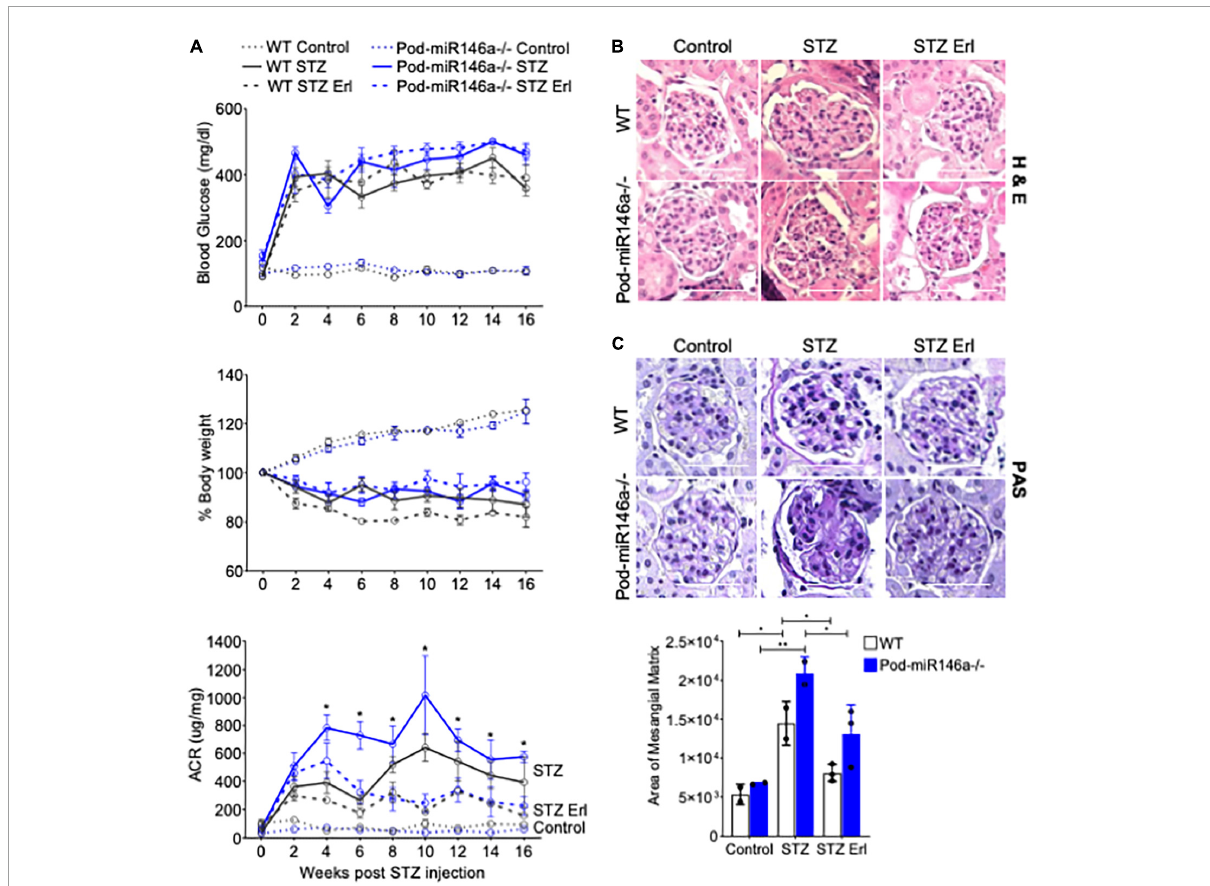
FIGURE4 STZ accelerates glomerular injury in Pod-miR-146a − / − mice that is attenuated by erlotinib. (A) (Top) Graph showing levels of hyperglycemia in various animals, as measured by serum glucose levels (mg/dL) in each of the six groups, as indicated, post STZ administration and at various time-points, as indicated. Data shown are mean ± SEM ( n = 5). Treatment with erlotinib starting at 4 weeks after STZ-induction did not result in any change in level of hyperglycemia in either strain. Blood glucose levels remained unchanged in the non-STZ treated mice; (Middle) Graph showing levels of weight loss upon in various animals in each of the six groups, as indicated, post STZ administration and at various time-points, as indicated. Data shown are mean ± SEM ( n = 5). WT and Pod-miR146a animals displayed equal levels of weight loss upon STZ-induced hyperglycemia that was unaffected by treatment with erlotinib; (Bottom) Graph showing the albumin to creatinine ratio ( µ g/mg) in the urine of mice from each of the six groups, as indicated, post STZ administration and at various time-points, as indicated. Statistics were performed using one-way ANOVA. Data shown are mean ± SEM ( n = 5). * p < 0.05. (B) Representative images showing histochemical analyses with H&E staining of kidney tissues from each of the six groups of animals at end point. Scale bar, 50 µ m. (C) Representative images showing histochemical analyses with PAS staining of kidney tissues from each of the six groups of animals at end point. Scale bar, 50 µ m. Graph showing quantified mesangial matrix from the PAS-stained sections. Data shown are normalized to the level of staining in control tissue and are mean ± SEM ( n = 3). * p < 0.05; ** p <